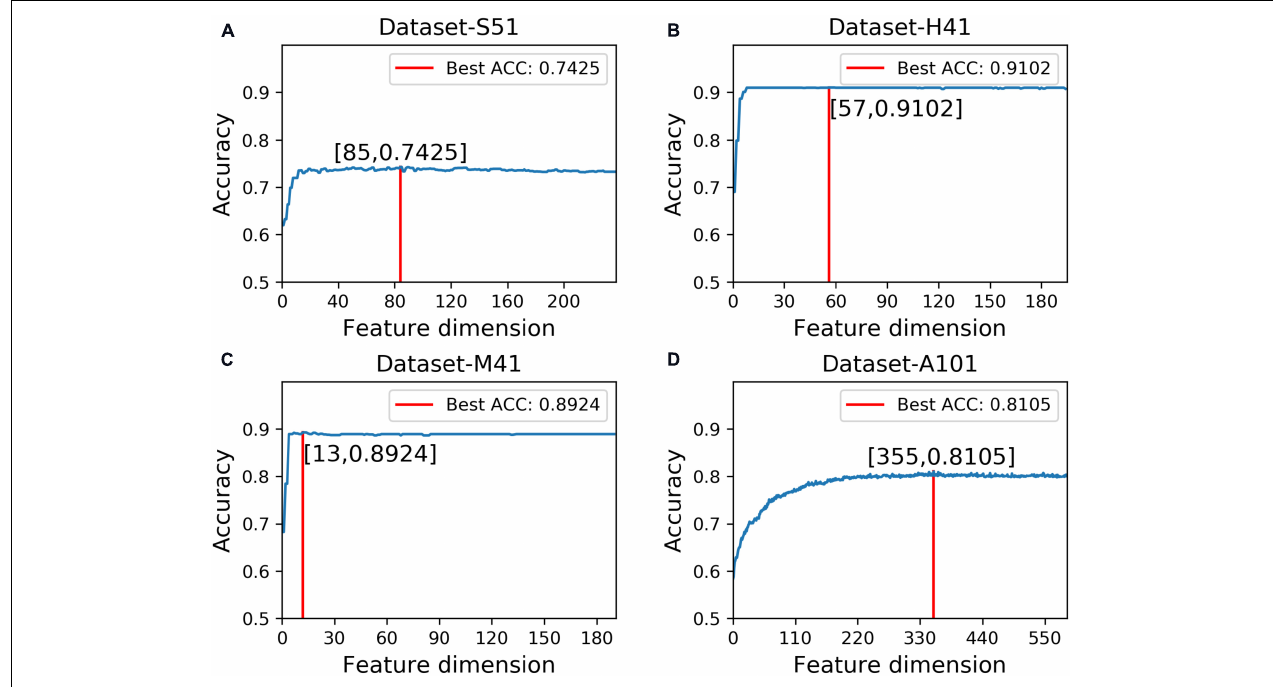
FIGURE 4 | Results of feature selection via varying the feature number. (A) denotes the results of feature selection on Dataset-S51. (B) denotes the results of feature selection on Dataset-H41. (C) denotes the results of feature selection on Dataset-M41. (D) denotes the results of feature selection on